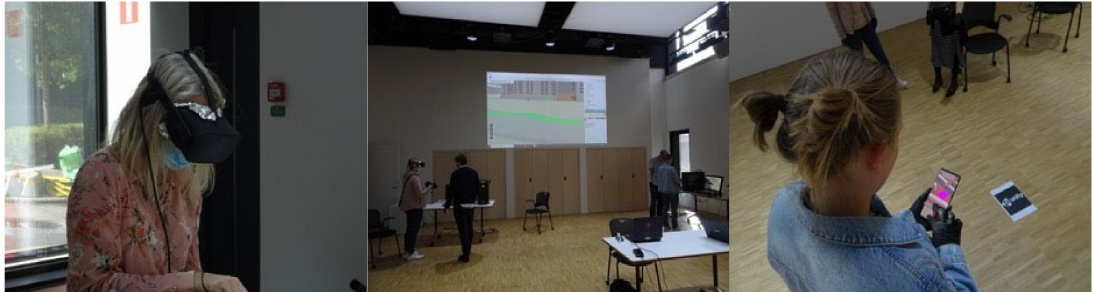
Figure 4. Stakeholder communication at workshops in Phase